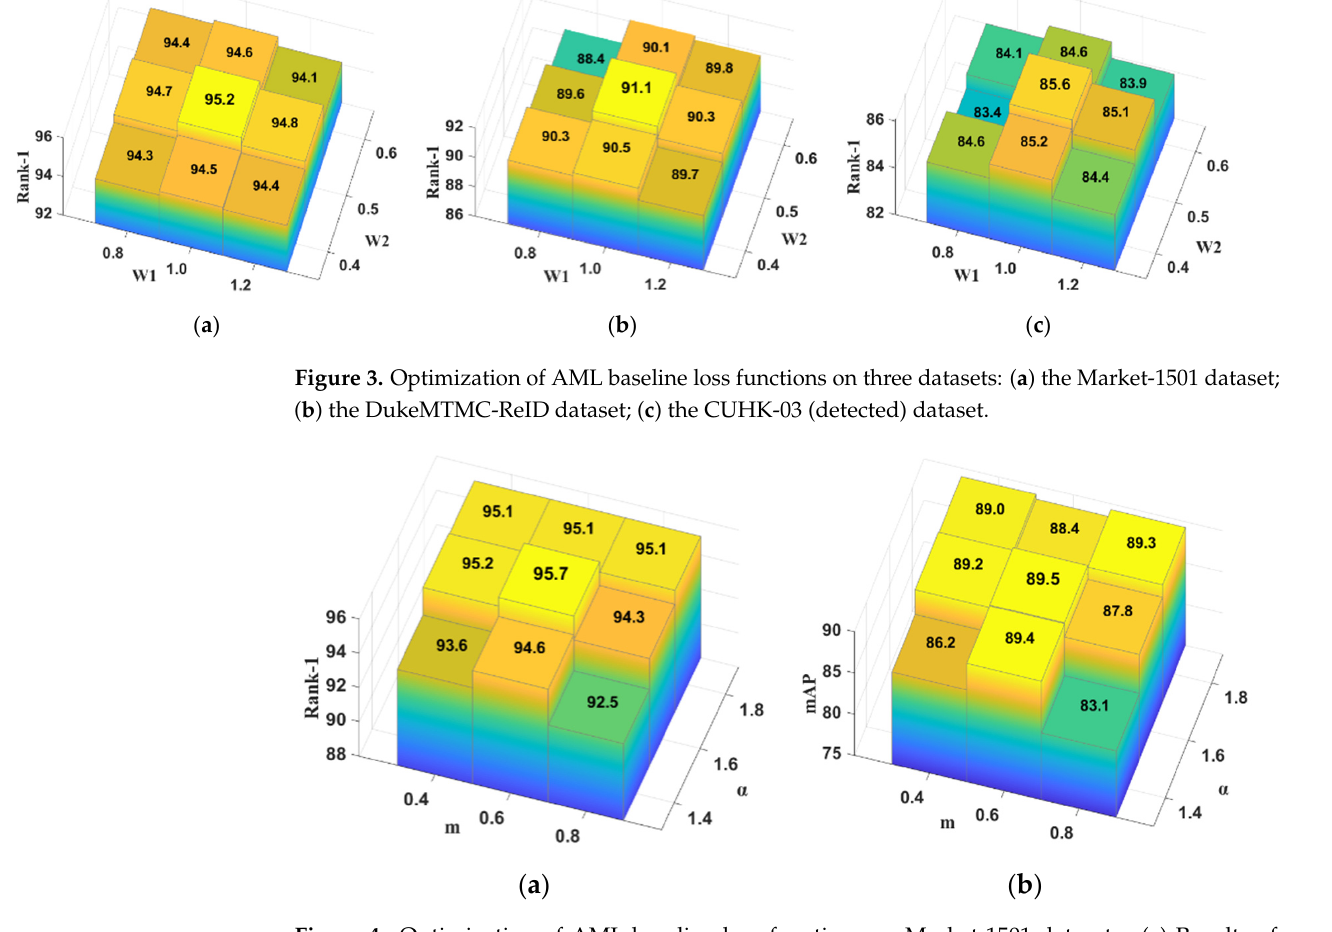
Figure 3. Optimization of AML baseline loss functions on three datasets: ( a ) the Market-1501 dataset; ( b ) the DukeMTMC-ReID dataset; ( c ) the CUHK-03 (detected) dataset.